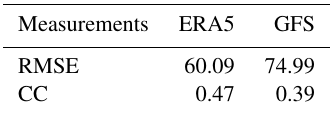
Table 1. The RMSE (µgm − 3 ) and correlation coefficient (CC) of PM 2 . 5 concentrations between simulations initialized by ERA5 and GFS and observations averaged over 80